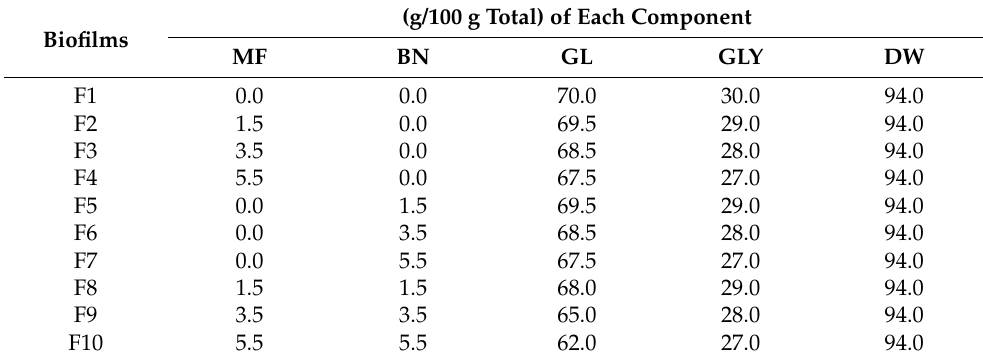
Table 1. Biofilm formulations produced by